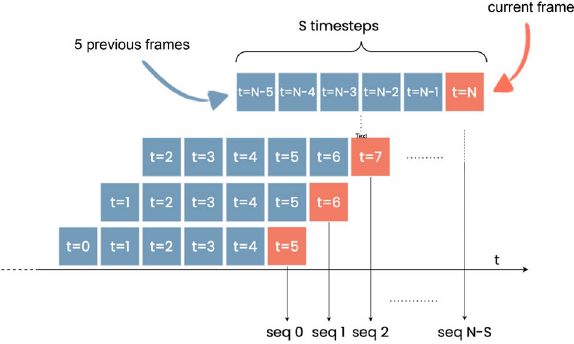
Figure 3. Sequence generation. The sequence generated for each frame included the S − 1 previous frames.